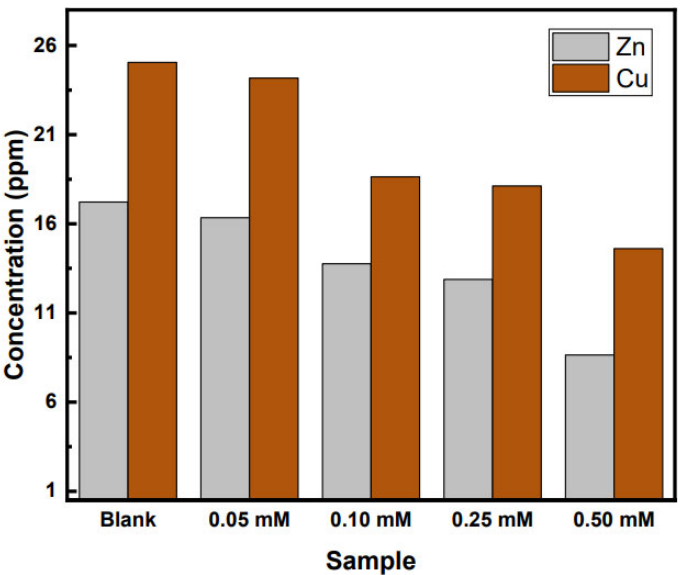
Figure 3. Copper and Zinc concentrations after an immersion time of 48 h in 0.5 M H 2 SO 4 .